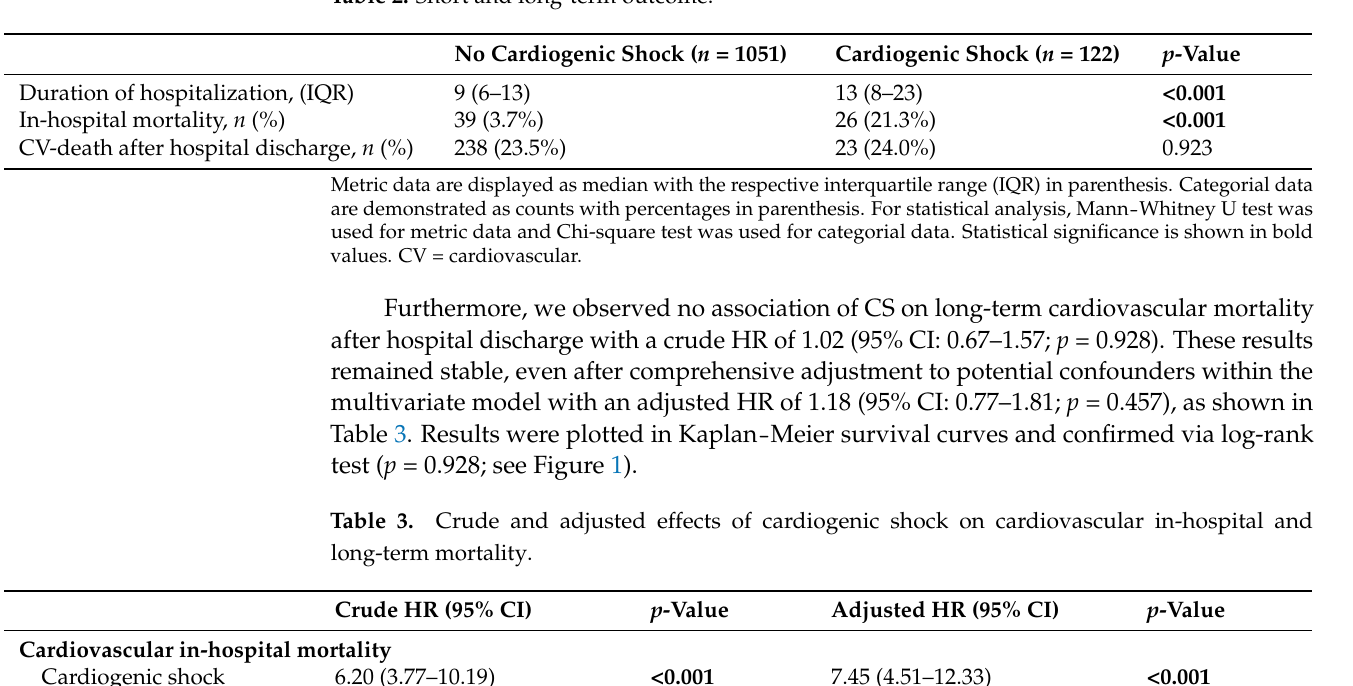
Table 2. Short and long-term outcome.